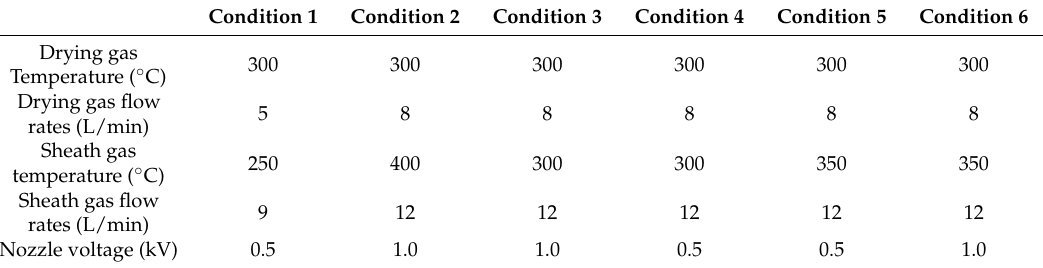
Table 1. Six different ion source parameter combinations.